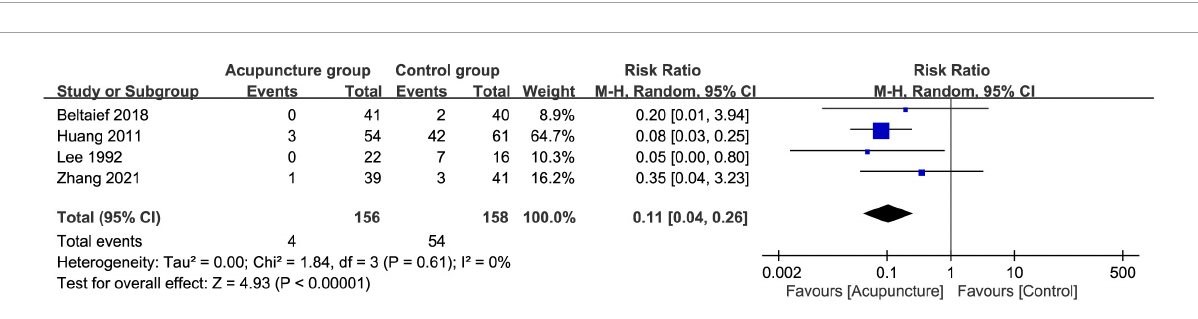
FIGURE11 Trial sequential analysis of the weight of evidence supporting the difference in pain score at 30–60 min between the acupuncture and control groups.